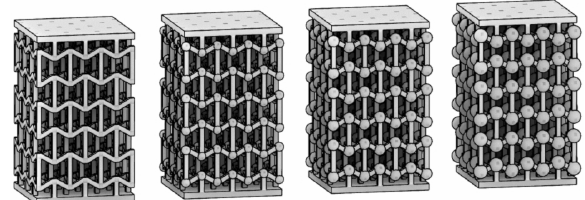
Figure 2. STL models for 3d printing.